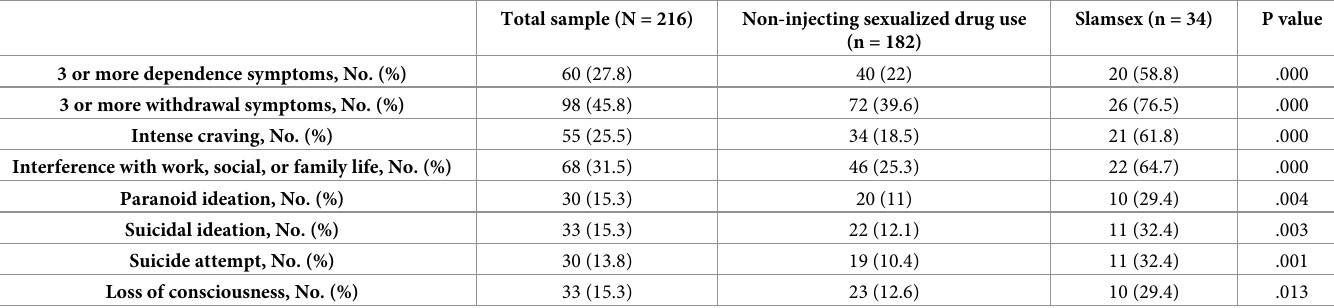
Table 2. Self-reported psychiatric symptoms during and after non-injecting sexualized drug use and slamsex. Total sample (N =